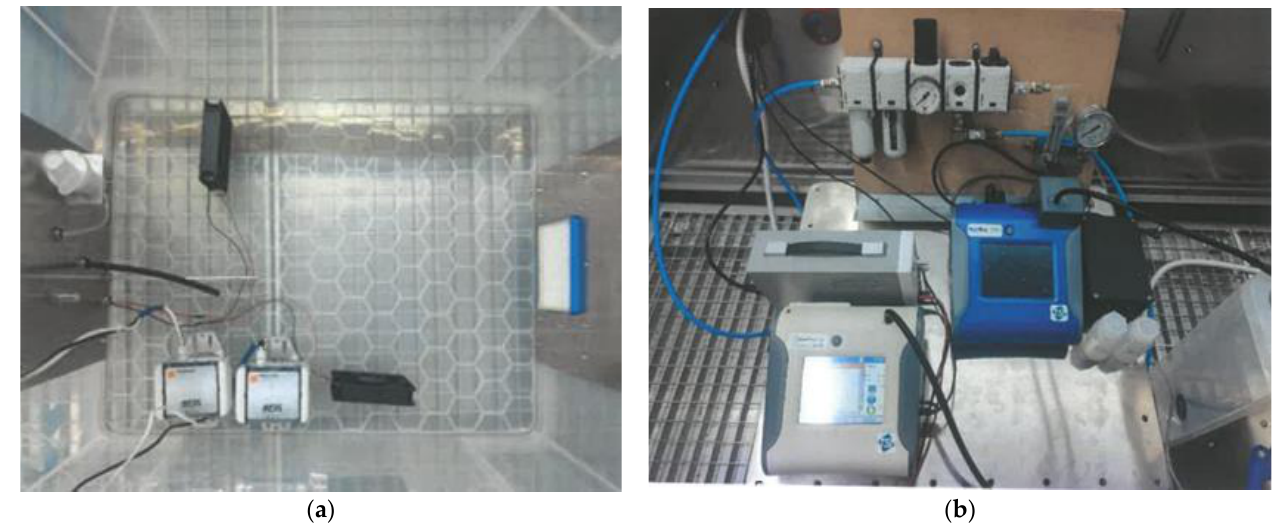
Figure 10. SEZO AM sensors in the dust chamber ( a ) and pneumatic track, reference device, and necessary accessories for the test in the dust chamber ( b ).